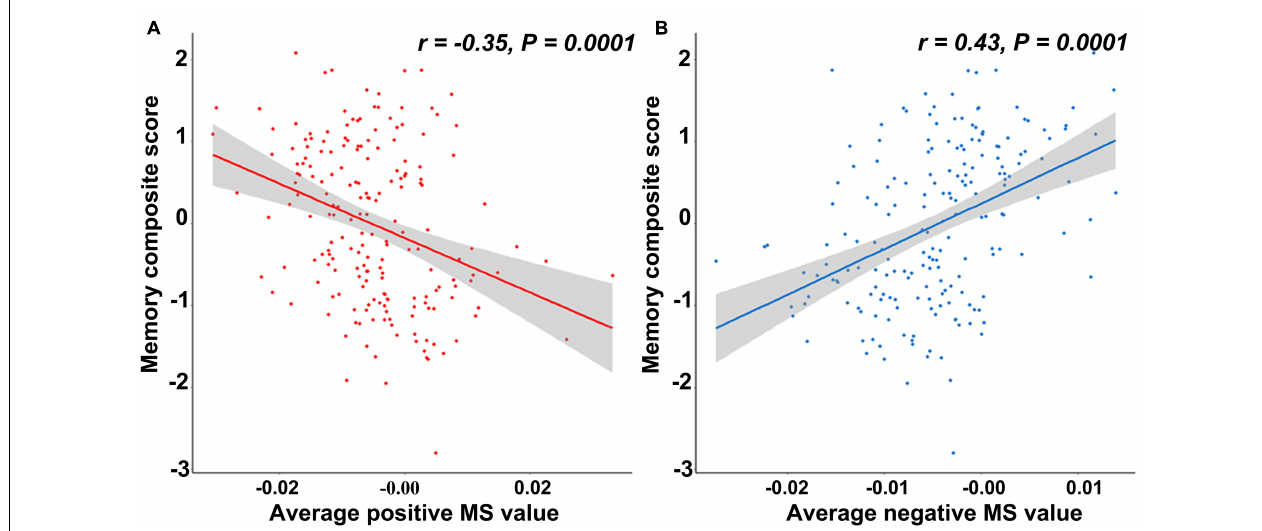
FIGURE 2 | The relationship between the memory composite score and regional morphometric similarity. (A) The average morphometric similarity in regions with significantly increased morphometric similarity in AD is significantly negatively correlated with the memory composite score. (B) The average morphometric similarity in regions with significantly decreased morphometric similarity in AD is significantly positively correlated with the memory composite score.